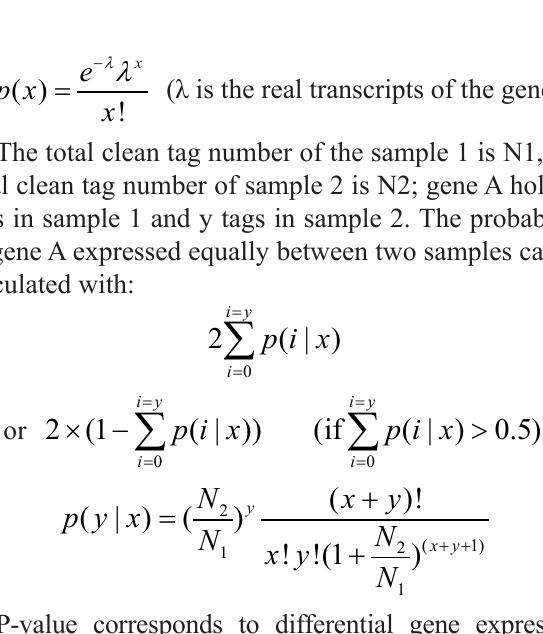
Figure 3. Agilent 2100 Bioanalyzer results of the p ooled RNA sample from the healthy control group (HT). The two tall peaks at 2000 and 4000 are the ribosomal RNA, RNA integrity number ( RIN ) of the p ooled total RNA were calculated from the bioanalyzer traces. P ooled total RNA has RNA integrity number ( RIN )